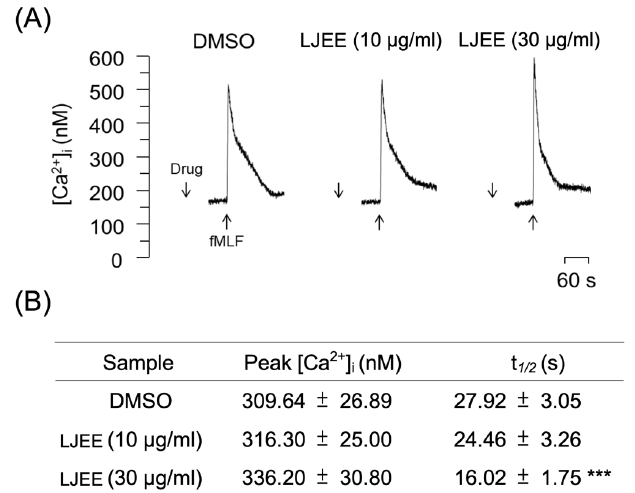
Figure 5. LJEE inhibited the [Ca 2+ ] i mobilization in fMLF-induced human neutrophils. ( A ) Representative patterns and ( B ) the [Ca 2+ ] i peak and t 1/2 are shown. Data are expressed as mean ± S.E.M. ( n = 7). *** p < 0.001, compared with the DMSO + fMLF group.